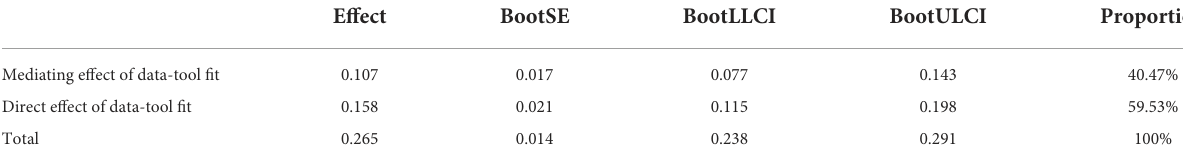
TABLE 9 Proportion of mediating, direct and total effect.